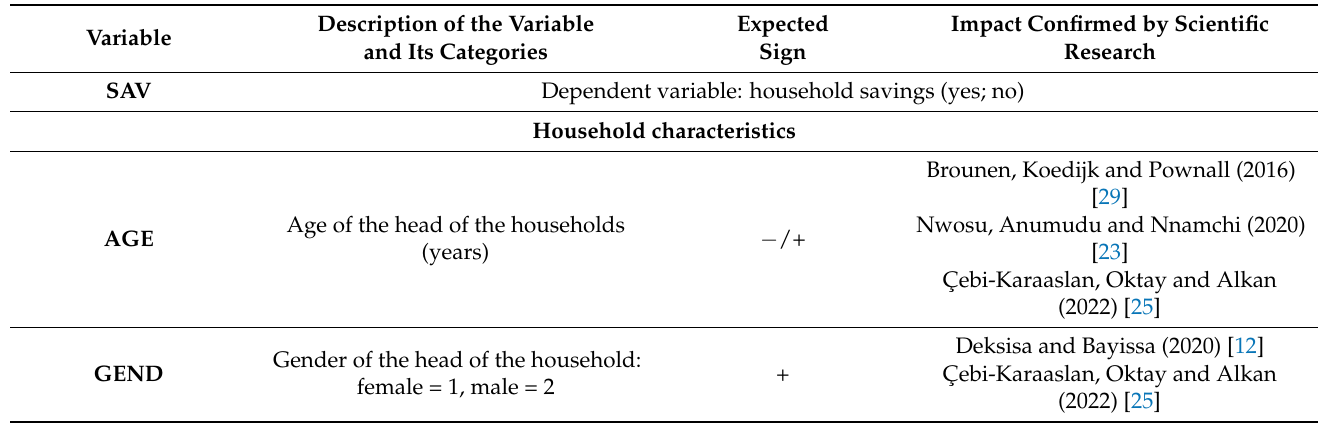
Table 1. Set of potential variables adopted for the